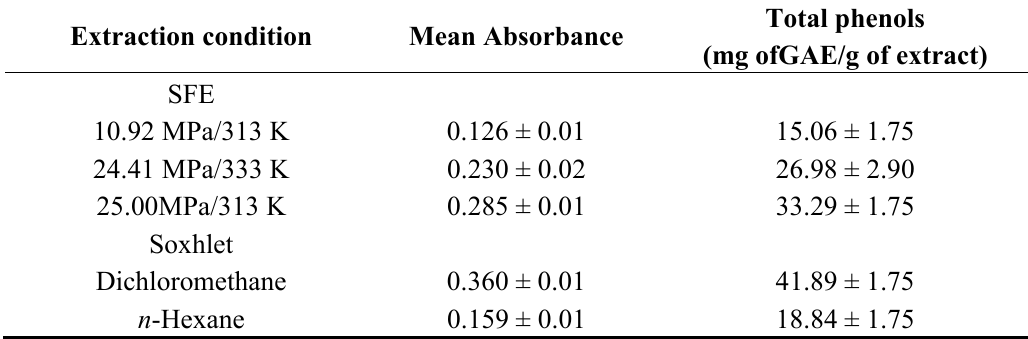
and Soxhlet extractions. 2